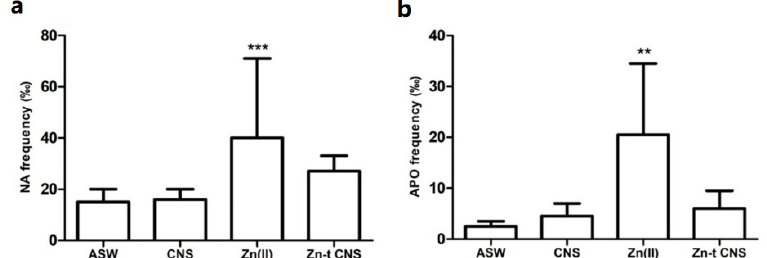
Figure 6. Frequencies (‰) of nuclear abnormalities (NA) ( a ) and apoptotic cells (APO) ( b ) in mussels’ gills after 48 h of exposure to the following experimental groups: ASW (control); Zn(II) (10 mg L − 1 of ZnCl 2 in ASW); Zn-t CNS (ZnCl 2 10 mg L − 1 contaminated ASW treated with CNS); CNS (ASW treated with only CNS). Results are shown as mean ± SD. (**) indicates significant differences with respect to the control group (ASW) ( p < 0.001). (***) indicates significant differences with respect to the control group (ASW) ( p < 0.0001).